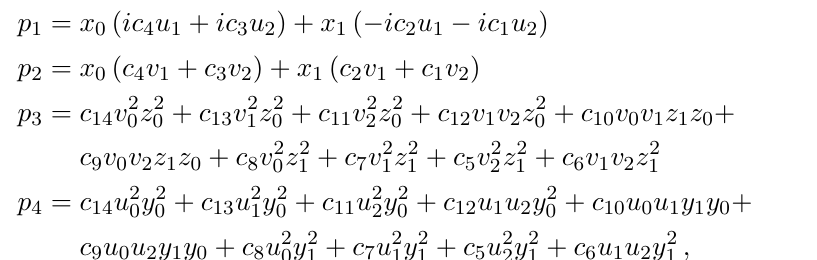
Figure 2. This (cid:12)gure illustrates the identi(cid:12)cation of curves within the curve class corresponding to the (cid:12)rst P 1 ambient space factor. Upon modding out (cid:0) = Z 4 , the four di(cid:11)erent curves in this curve class are identi(cid:12)ed, leaving a curve class with Gromov-Witten invariant 1 on X . consistent with this symmetry are given